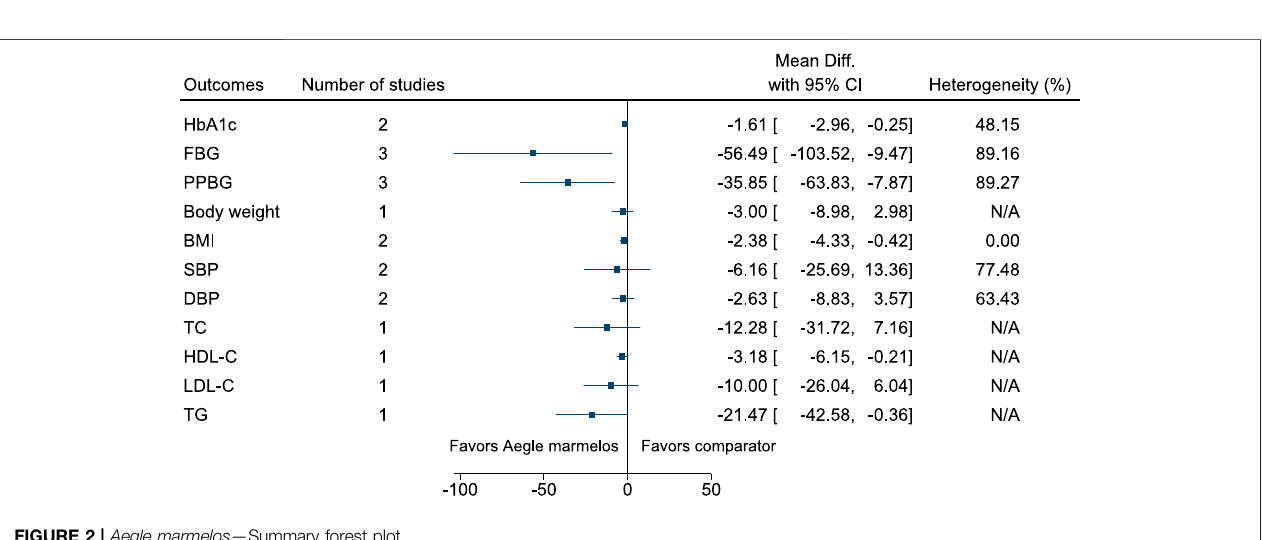
FIGURE 2 | Aegle marmelos — Summary forest